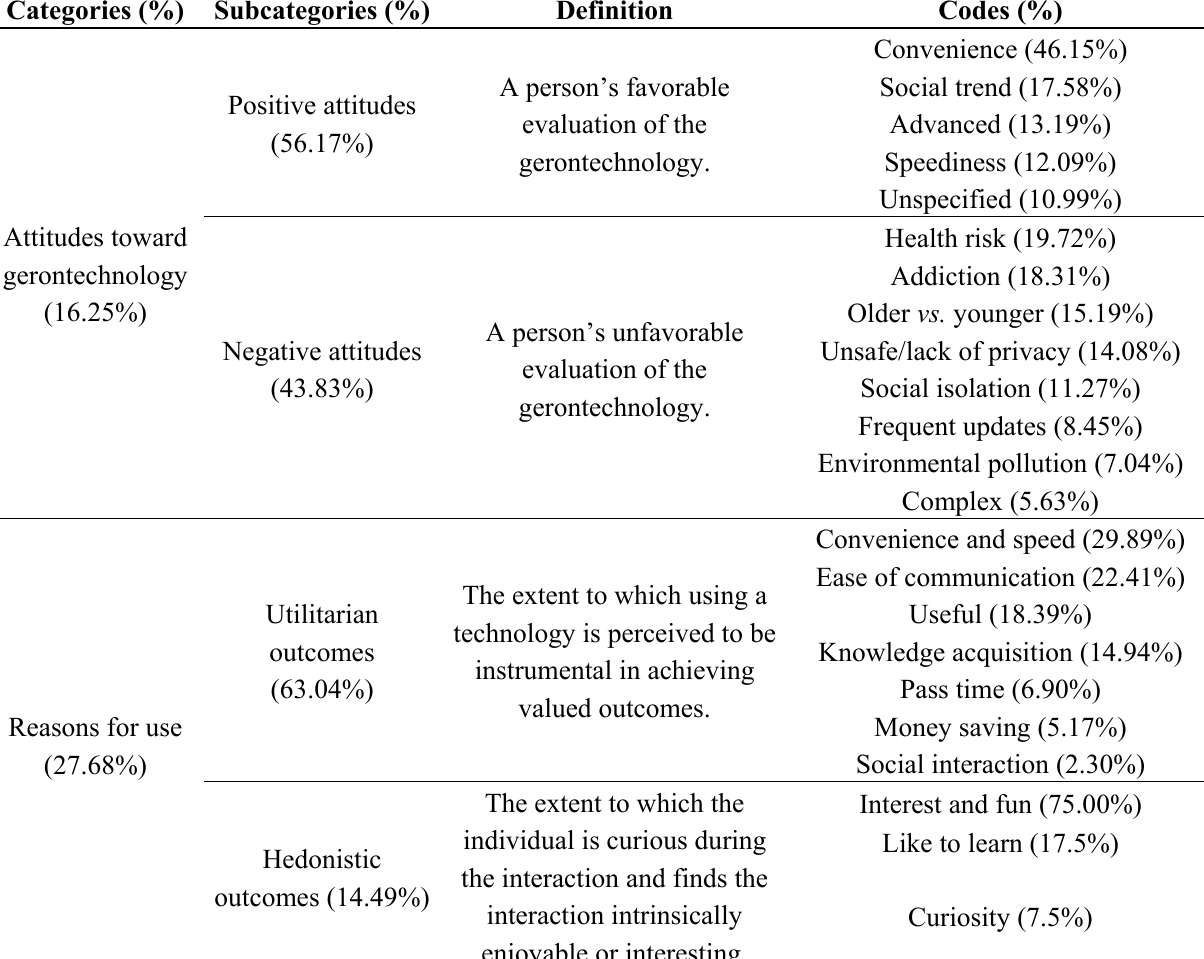
Table 3. The coding scheme and proportion of the code ( n =